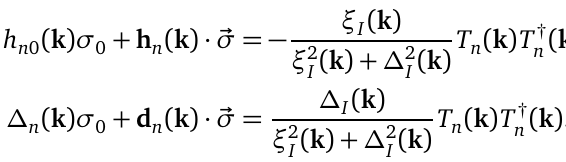
Figure 8: (a)-(d) Phase diagrams for the system as a function of the interlayer coupling strengths A and B for different spin orbit coupling strengths λ = : 0,0.06 t spectively. Each phase is characterized by three vectors Q SD of the semi-Dirac nodes as illustrated in (e). The semi-Dirac points shown in (e) are realised for λ = 0.17 t and A = − 0.68 and B = − 0.34. The tight-binding parameters are described in L the